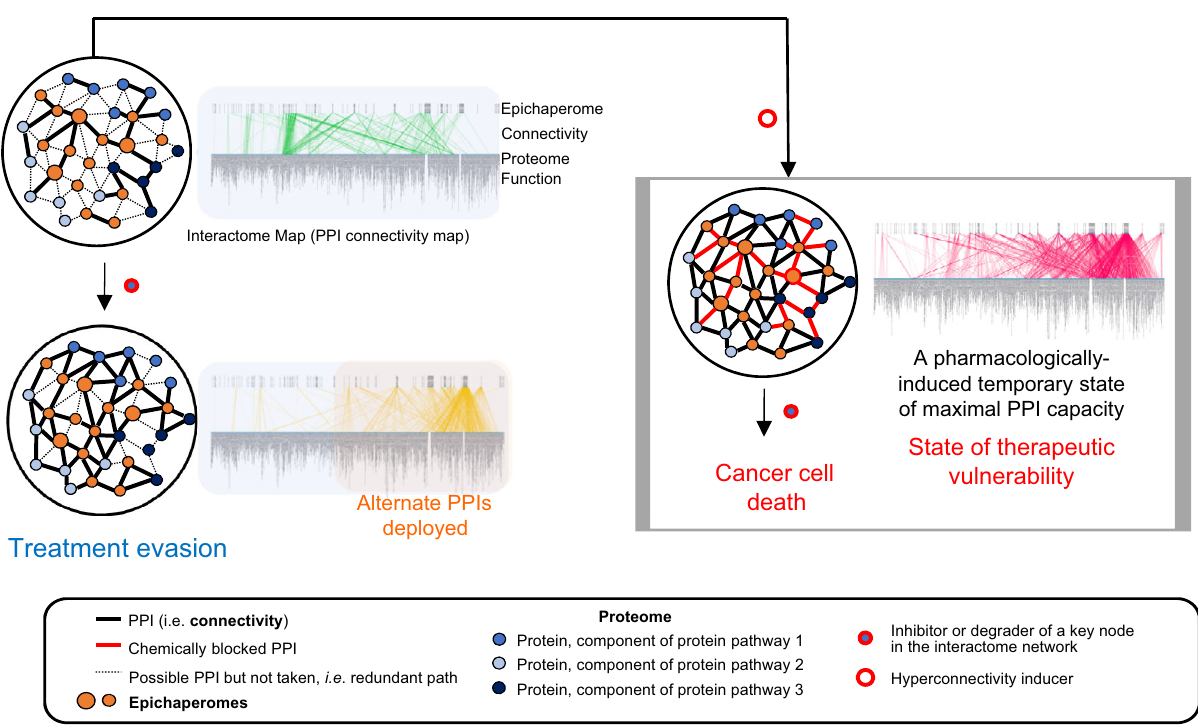
Fig. 10 Summary of fi ndings. Interactome network plasticity in cancer, which arises from highly redundant signalling pathways, poses a real challenge to therapy and accounts for treatment resistance. Herein, we leverage discoveries in the biology of cellular stress linking cellular vulnerability to hyperconnectivity in PPI networks to propose a method for pharmacologically rewiring PPI networks at proteome-wide level for therapeutic vulnerability. By employing this approach, we provide proof-of-principle in cancer that by pharmacologically controlling interactome connectivity through epichaperomes, we anticipate the trajectory of PPI changes and co-opt dynamic cellular PPI networks to in situ engineer a state of hyperconnectivity. By forcing PPI networks into a hyperconnected state, we create therapeutic sensitivity, effectively making controllability into a powerful treatment strategy. This means existing treatments may be more effective than previously observed if controllability measures are exercised in tandem with drug treatment whereby cancerous cells are forced into a state of interactome hyperconnectivity. Several inhibitors/degraders of PPI nodes are already in clinical use or in development (ex. inhibitors or degraders such as PROTACS and others that target nodes in signalling networks), making this approach both timely and impactful. This treatment paradigm is not a combination method per se, because the hyperconnectivity inducer is used once to prime the tumour, followed by current therapy. It also differs from synthetic lethality where simultaneous perturbation of two or more genes is required for cellular